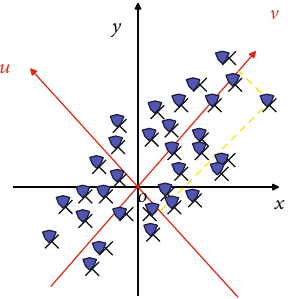
Figure 1: Schematic diagram of the registration principle based on covariance